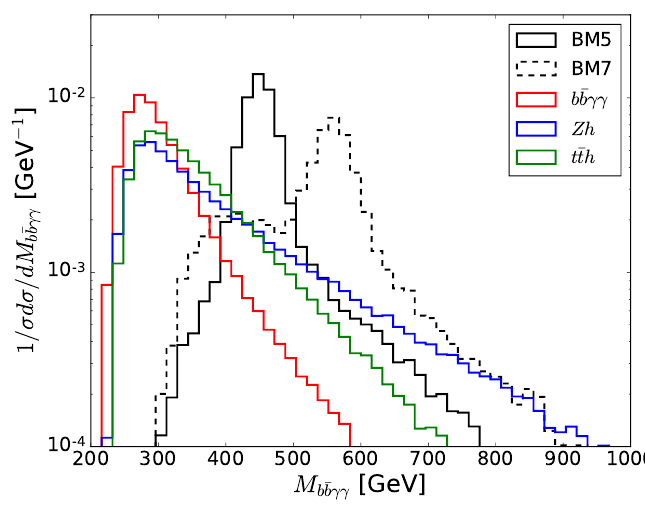
Figure 5 . The b (cid:22) b(cid:13)(cid:13) invariant mass distribution for signals, BM5 (solid black) and BM7 (dashed black) benchmark points, and the main